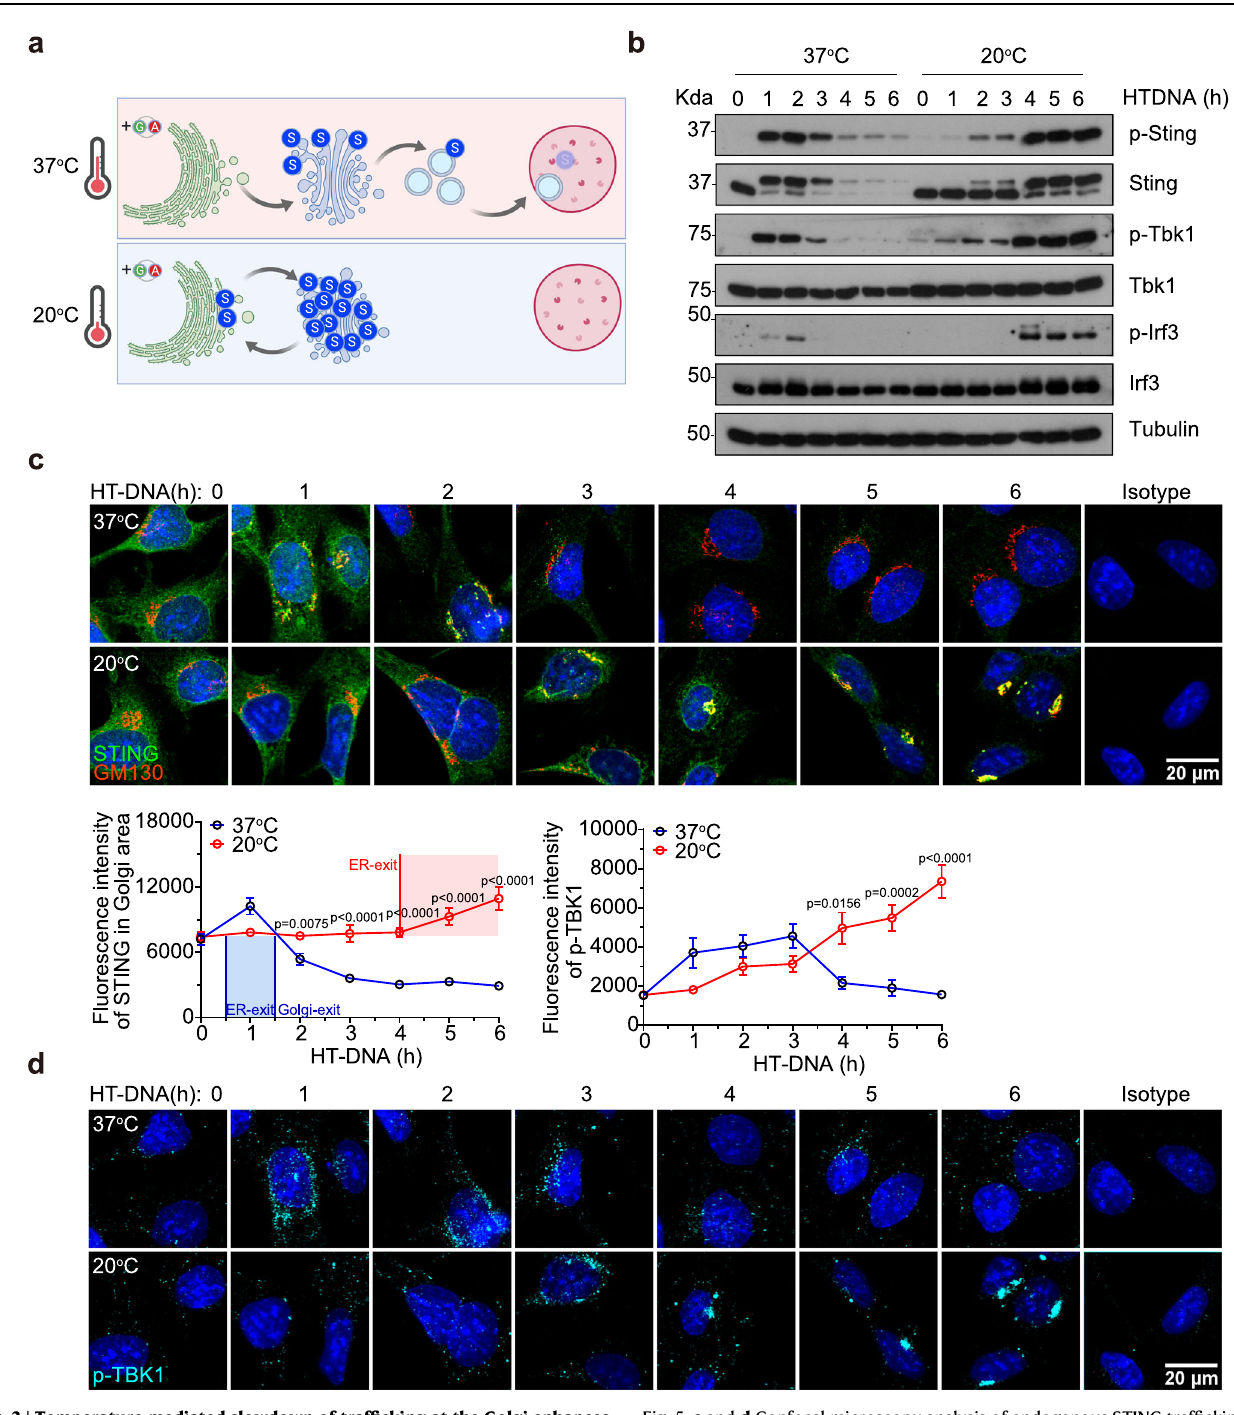
Fig. 5. c and d Confocal microscopy analysis of endogenous STING traf fi cking and signaling. Wild-type MEFs were stimulated with HT-DNA (1 µ g/mL) while incubated at 37°C or 20°C. Endogenous STING traf fi cking ( c , images on top, quanti fi cations atthe bottom) and signaling activation ( d , p-TBK1 quanti fi cation on top, images at the bottom) were analyzed as in Fig. 2g, h. Scale bar, 20 µ m. n =3. Data are repre- sentativeofatleastthreeindependentexperiments.Atleast17cellsintwodifferent views were analyzed ( c , d ). Data ( c , d ) are shown as mean±s.e.m. P values were determined by Two-way ANOVA ( c , d